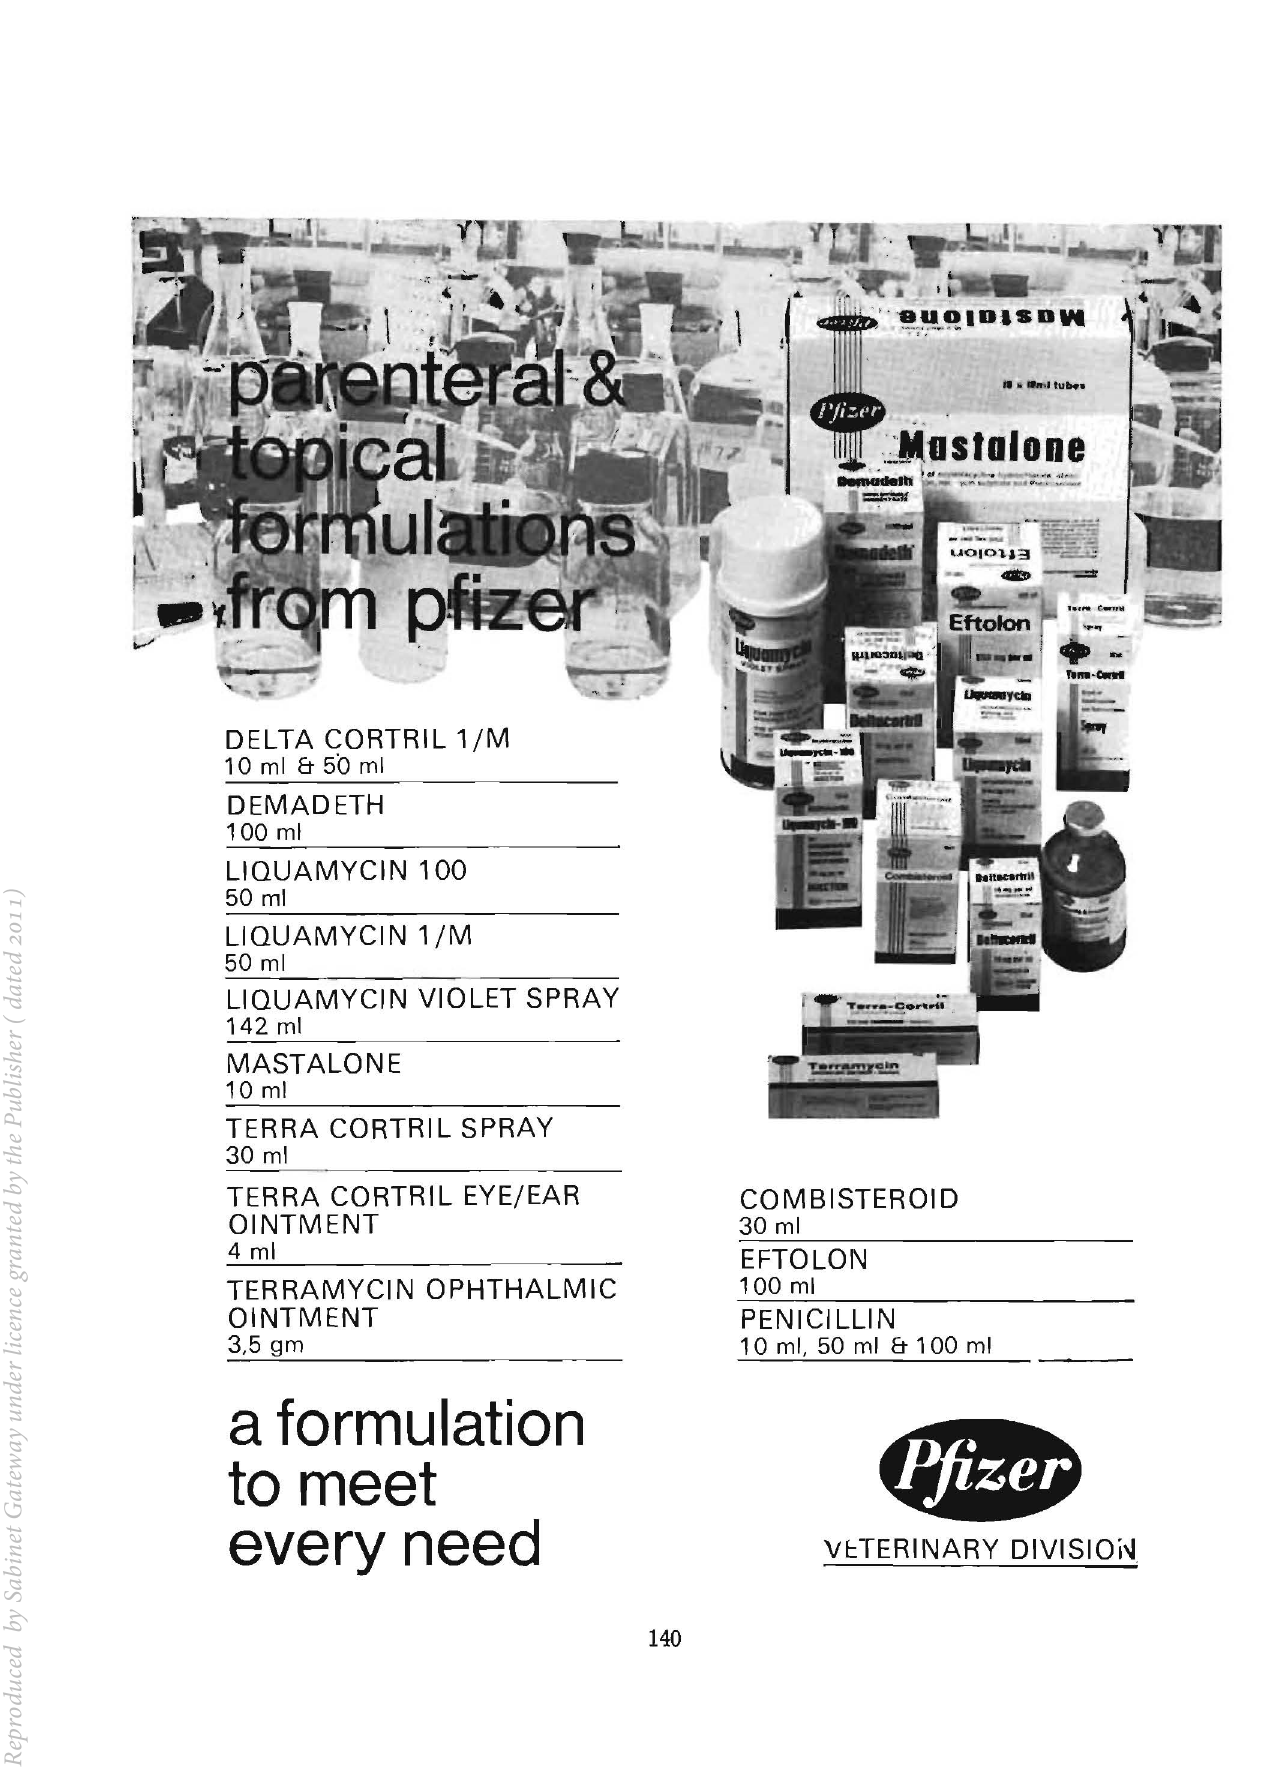
VI:TERINARY DIVISIOi\l